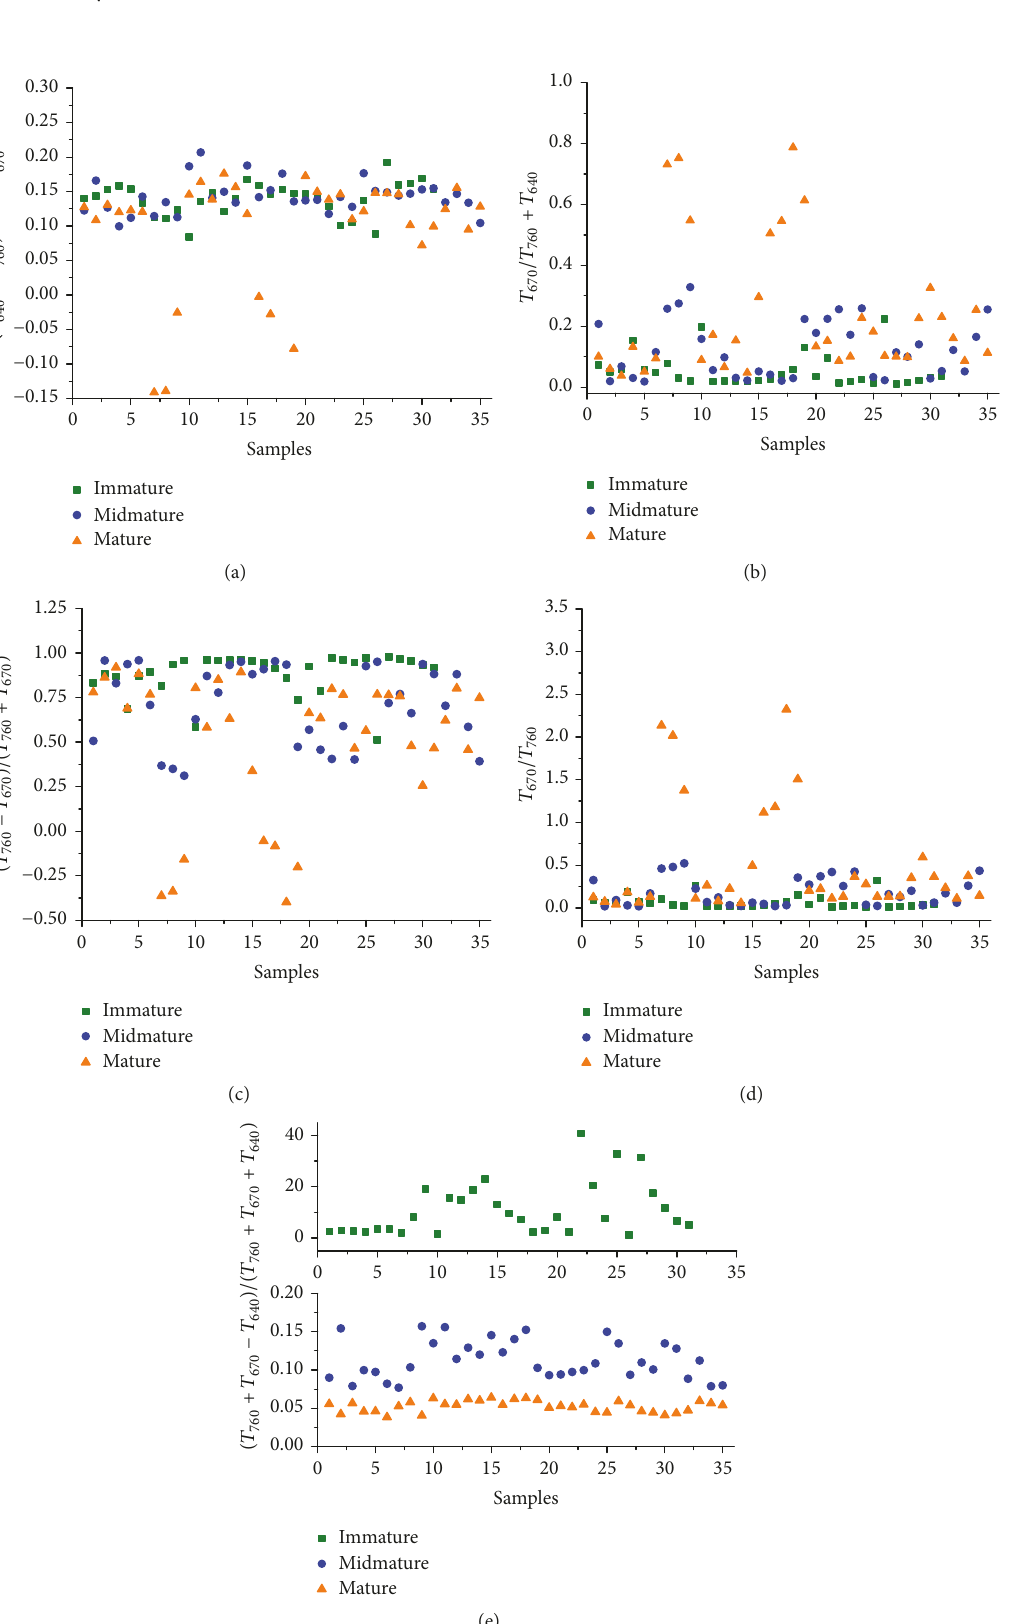
Figure 3: Multispectral indexes distribution of navel oranges at three different maturity